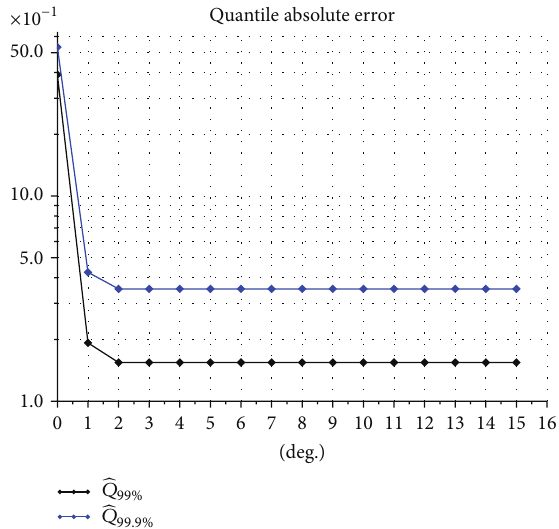
̂𝑄 ̂𝑄 99 % and 99.9 % of = 110 . 0